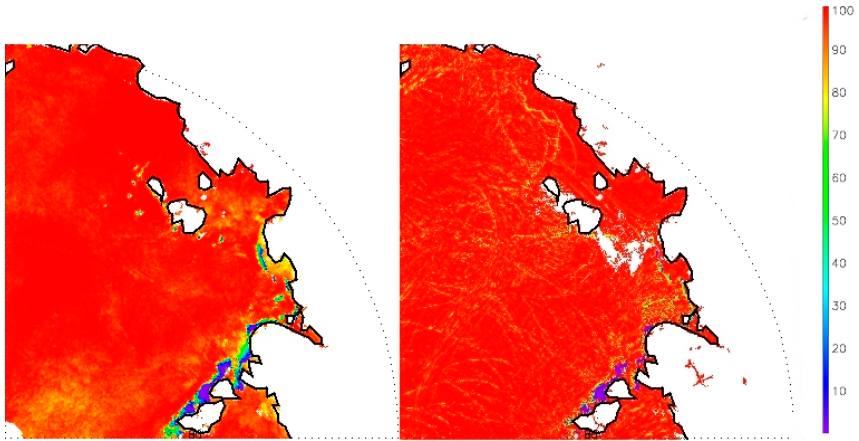
Figure 10. Ice concentration from SSMIS ( left ); and from VIIRS daily composite ( right ) over portion of the Arctic (longitude: 90–180, latitude: 70–90) on 20 February 2015. The North Pole is in the lower left corner. White areas in the SSMIS denote pixels flagged as either land or the area around the pole that is not covered by the instrument. White areas in the VIIRS data denote pixels flagged as either land or cloudy.